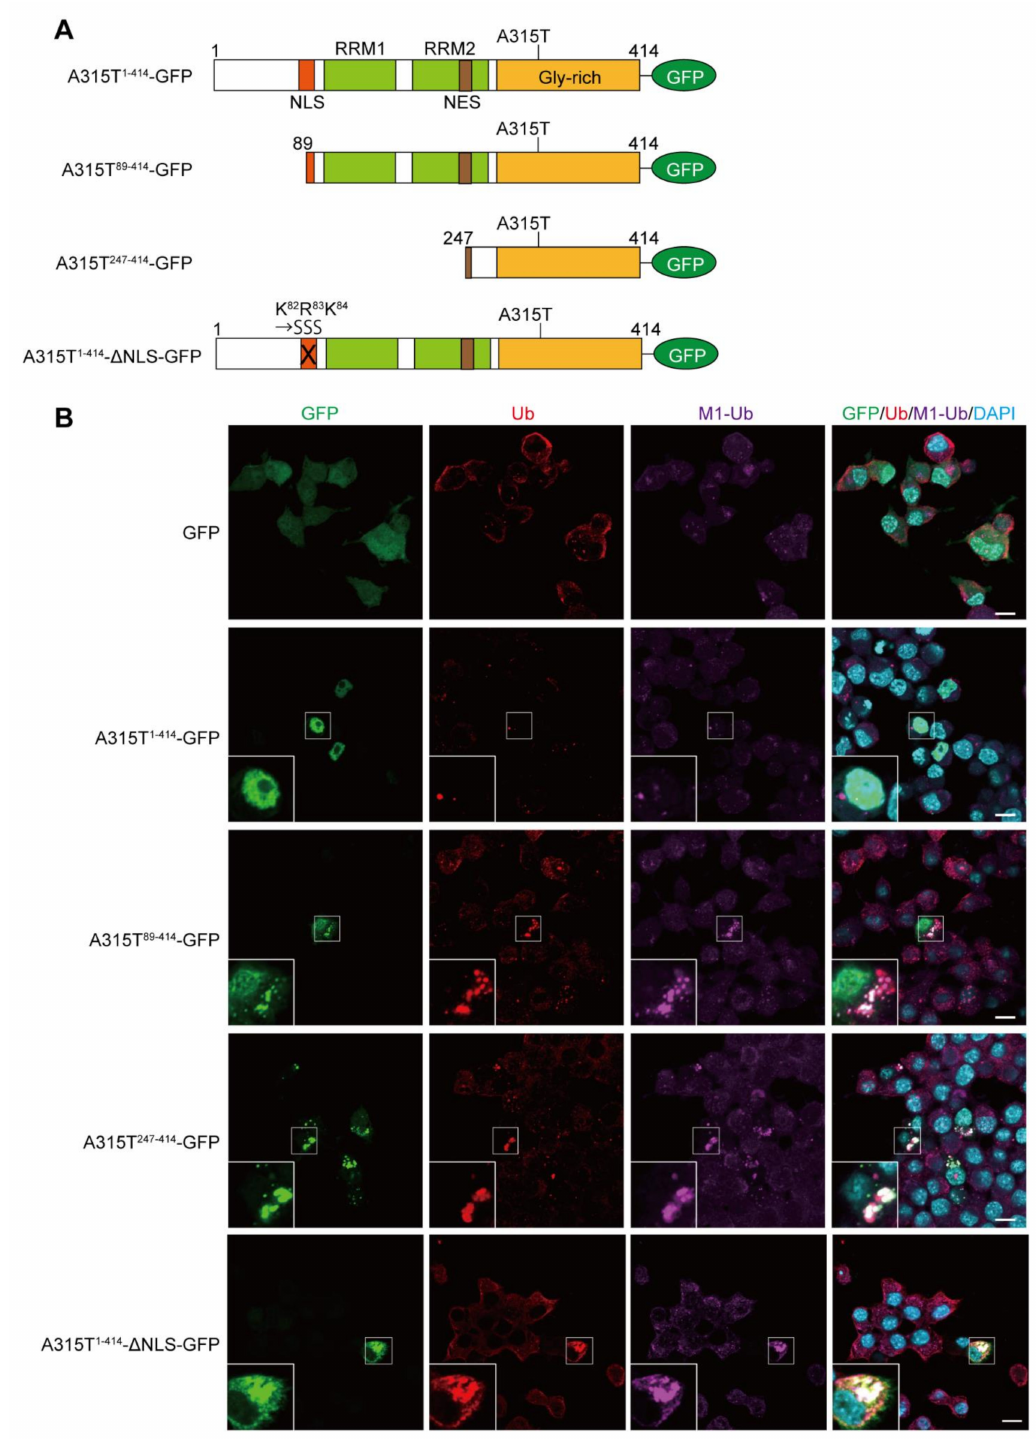
Figure 1. Linear ubiquitin is colocalized with cytoplasmic aggregates of truncated forms of A315T TDP-43. ( A ) Domain structures and constructed mutants of the C-terminally GFP-tagged TDP-43 with the ALS-associated A315T mutation are shown. NLS, nuclear localization signal; RRM—RNA recognition motif; NES—nuclear export signal. In A315T 1-414 - ∆ NLS-GFP, the K 82 -R 83 -K 84 amino acid sequence in NLS was replaced by S 82 -S 83 -S 84 . ( B ) Colocalization of linear ubiquitin with cytoplasmic aggregates of TDP-43. GFP and various A315T mutant of TDP-43-GFP were transiently expressed in Neuro2a cells, and the recruitments of pan-ubiquitin (Ub) and linear ubiquitin (M1-Ub) were visualized by immunofluorescence analyses. Inserts : Enlarged images of boxed regions. Bars = 10 µ